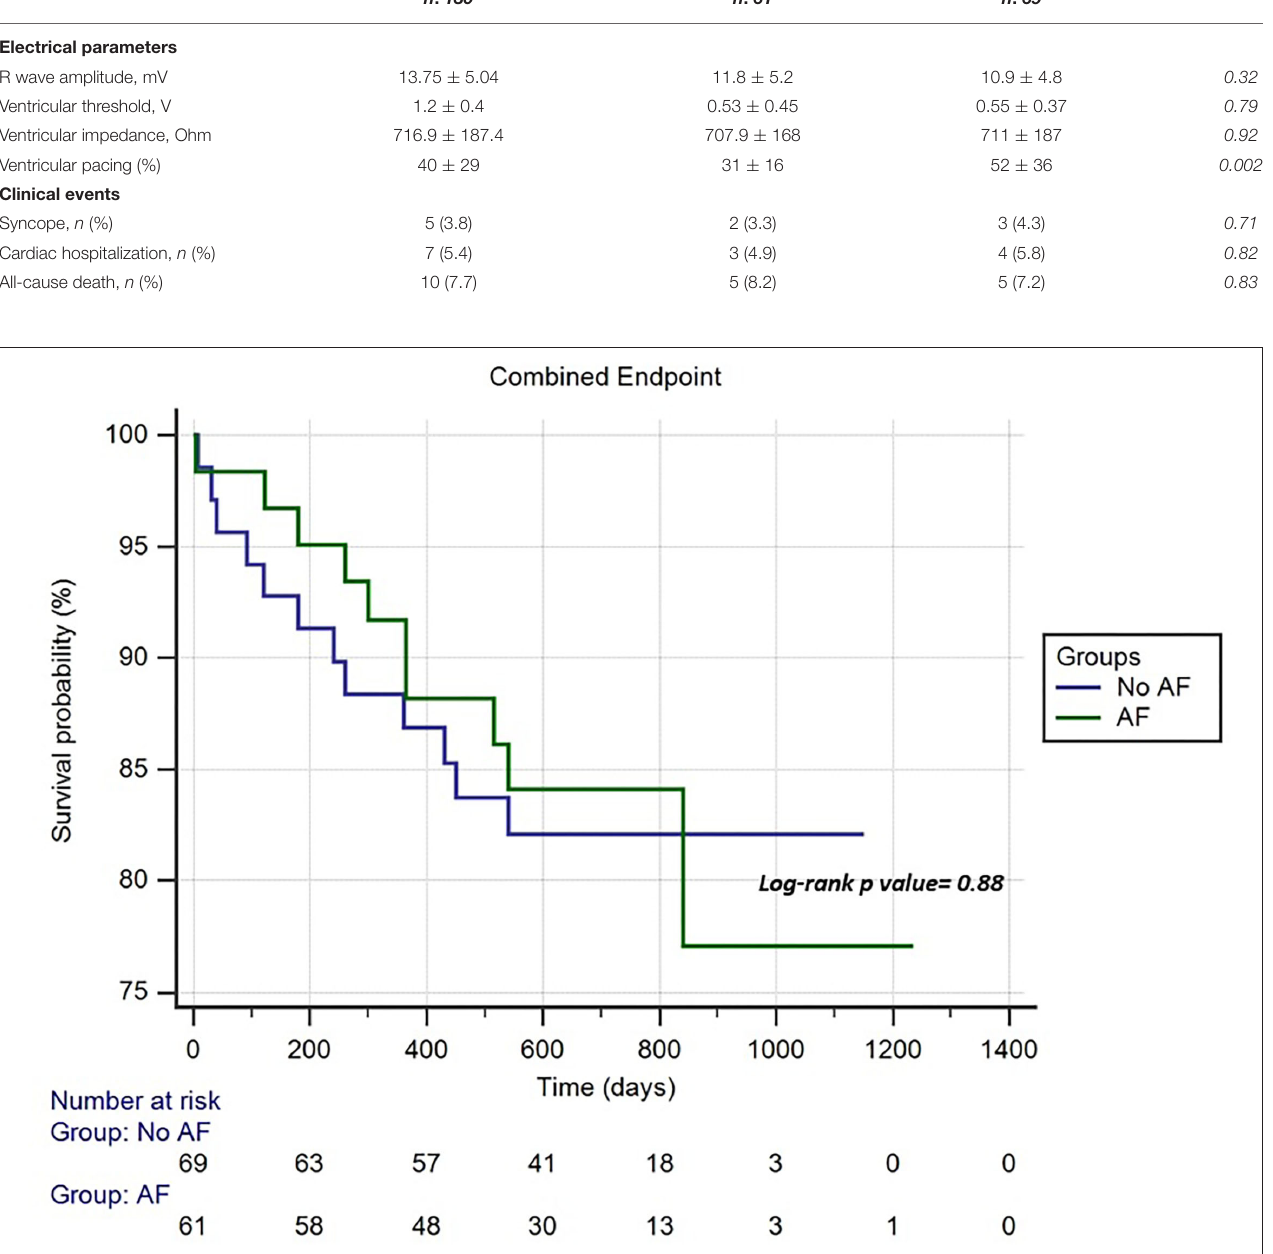
Overall population n : 130